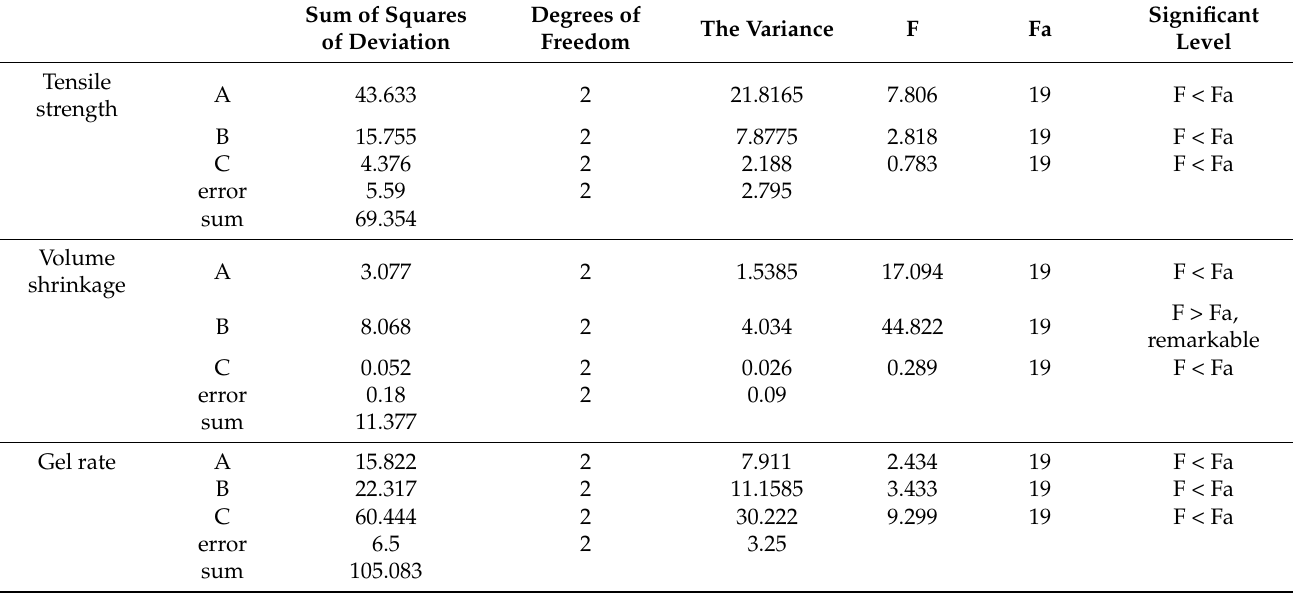
Table 5. Statistical analysis of the orthogonal